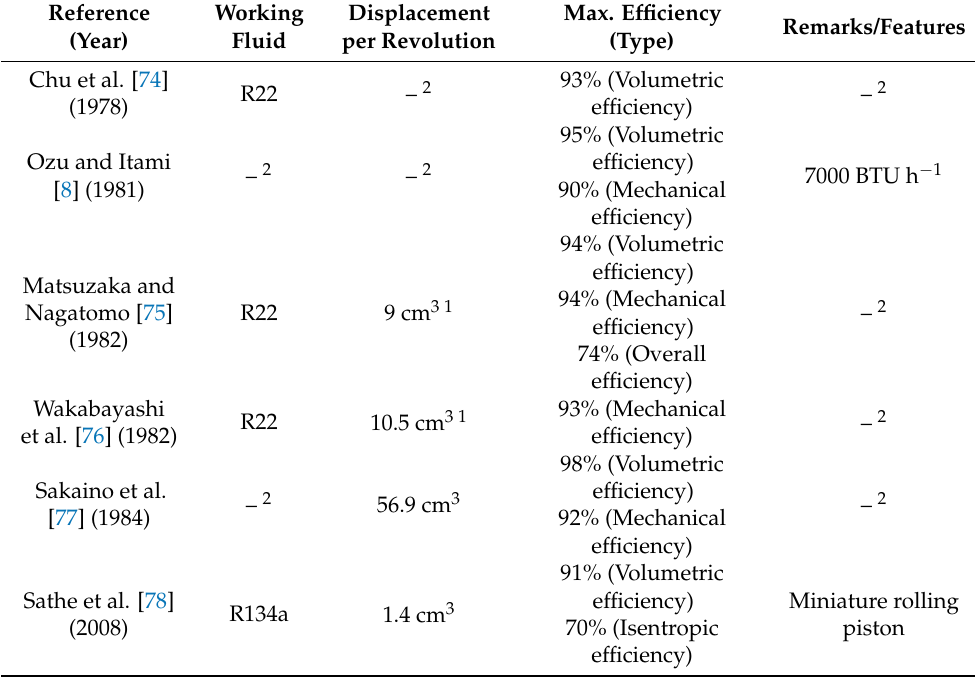
Table 5. Rolling piston compressor performance.